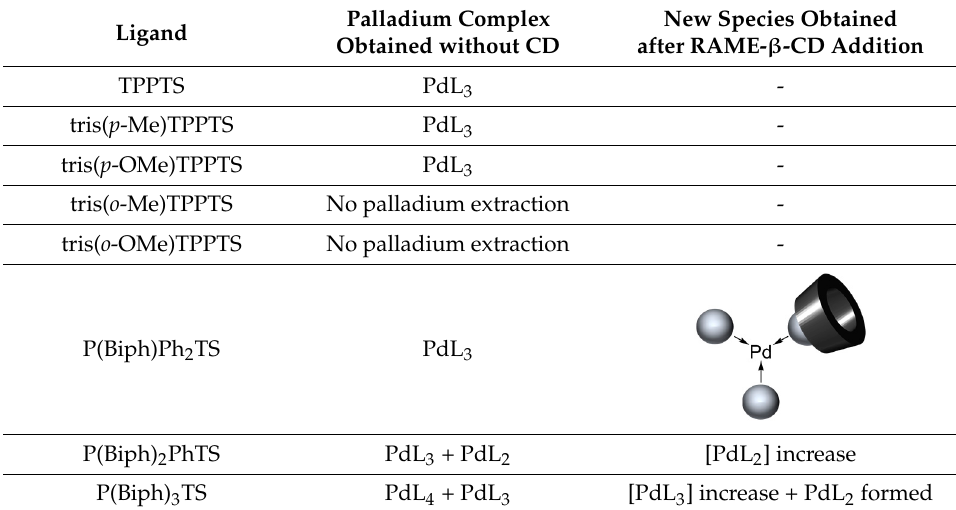
Figure 15. 31 P{ 1 H} NMR spectra of palladium complexes synthetized with P(Biph) 3 TS depending on temperature in the presence of 4 equiv. of RAME- β -CD towards the phosphane in D 2 O with a ligand concentration of 66 mM. Table 3. New organometallic species observed after RAME- β -CD addition (1 to 12 equiv. toward palladium) to a solution of the palladium complexes formed by extraction with an aqueous ligand solution (66 mM).